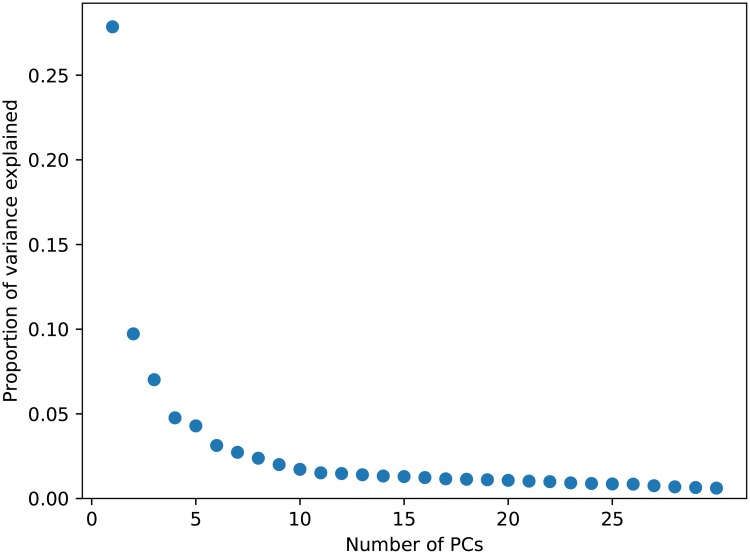
Scree plot obtained from PCA.